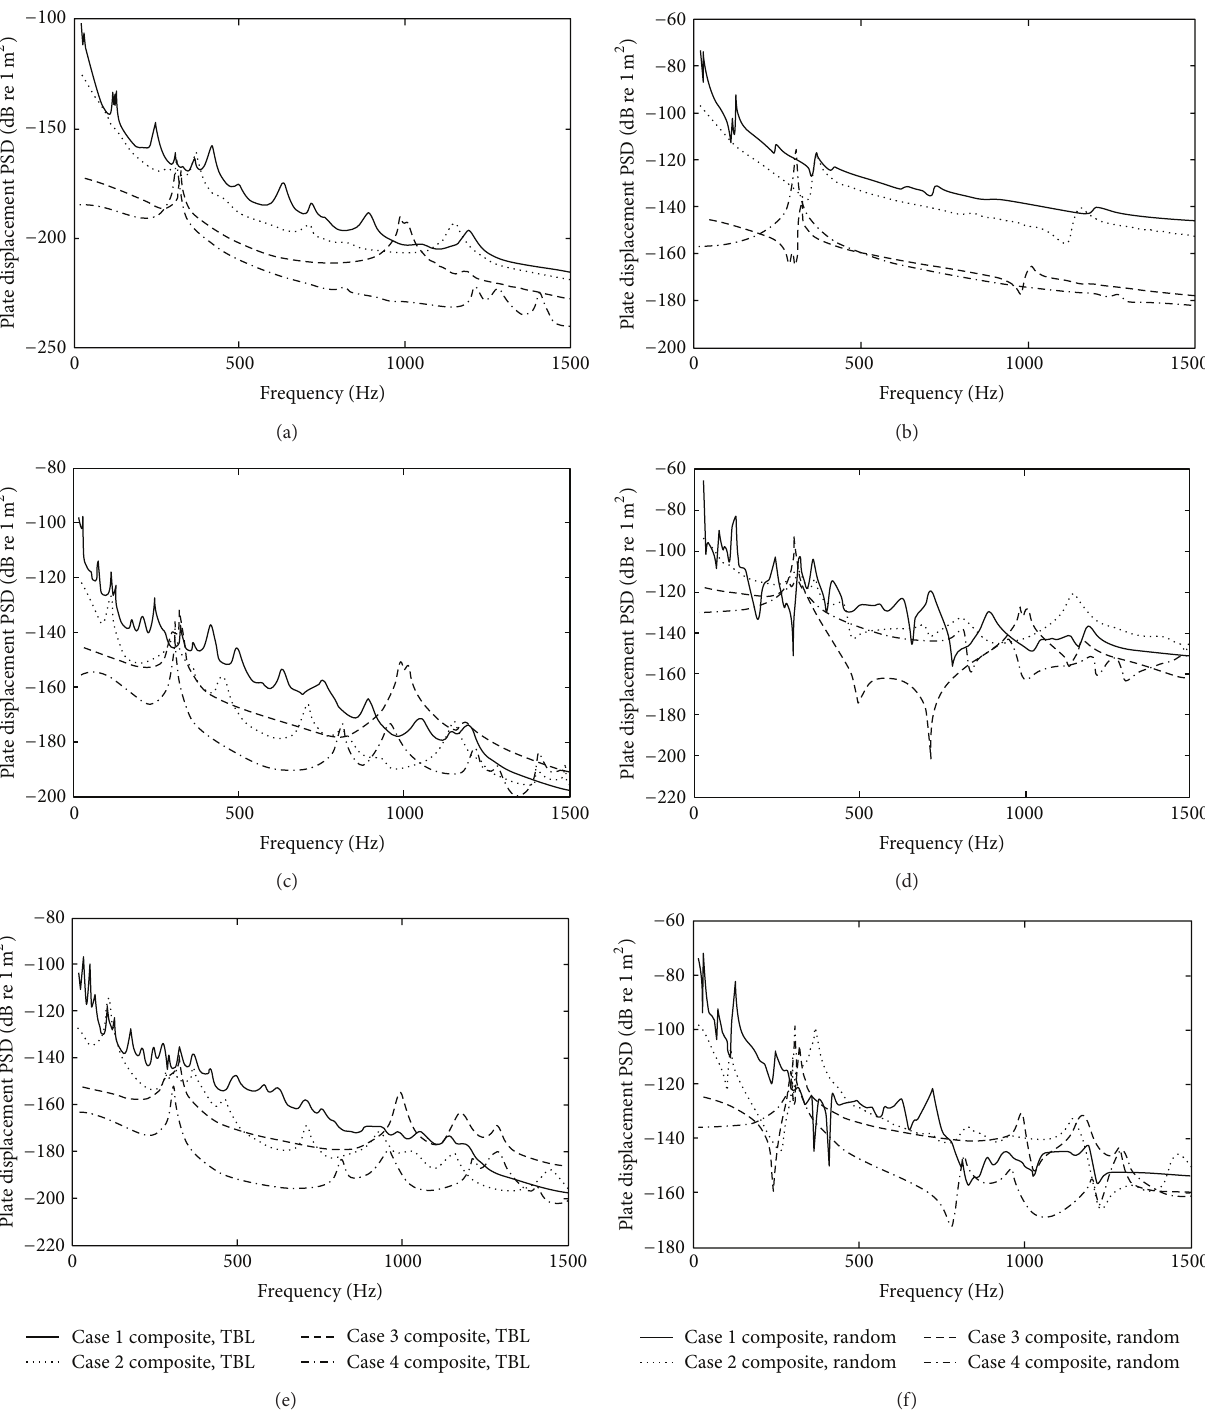
(𝑥 , 𝑦 ) = (0.3𝑎, 0.2𝑏) . 𝑤𝑤 near location 2 2